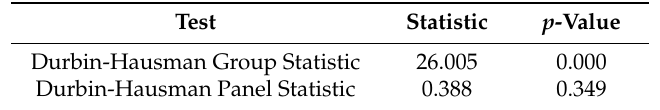
Table 5. Results of the Westerlund-Durbin-Hausman (2008) cointegration